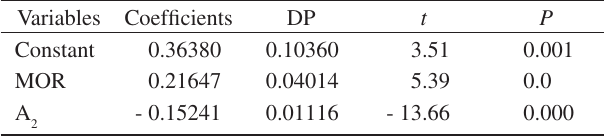
Table 5. Coefficients of regression of the independent variables DP . t . p . s . R 2 and n – reduced model.